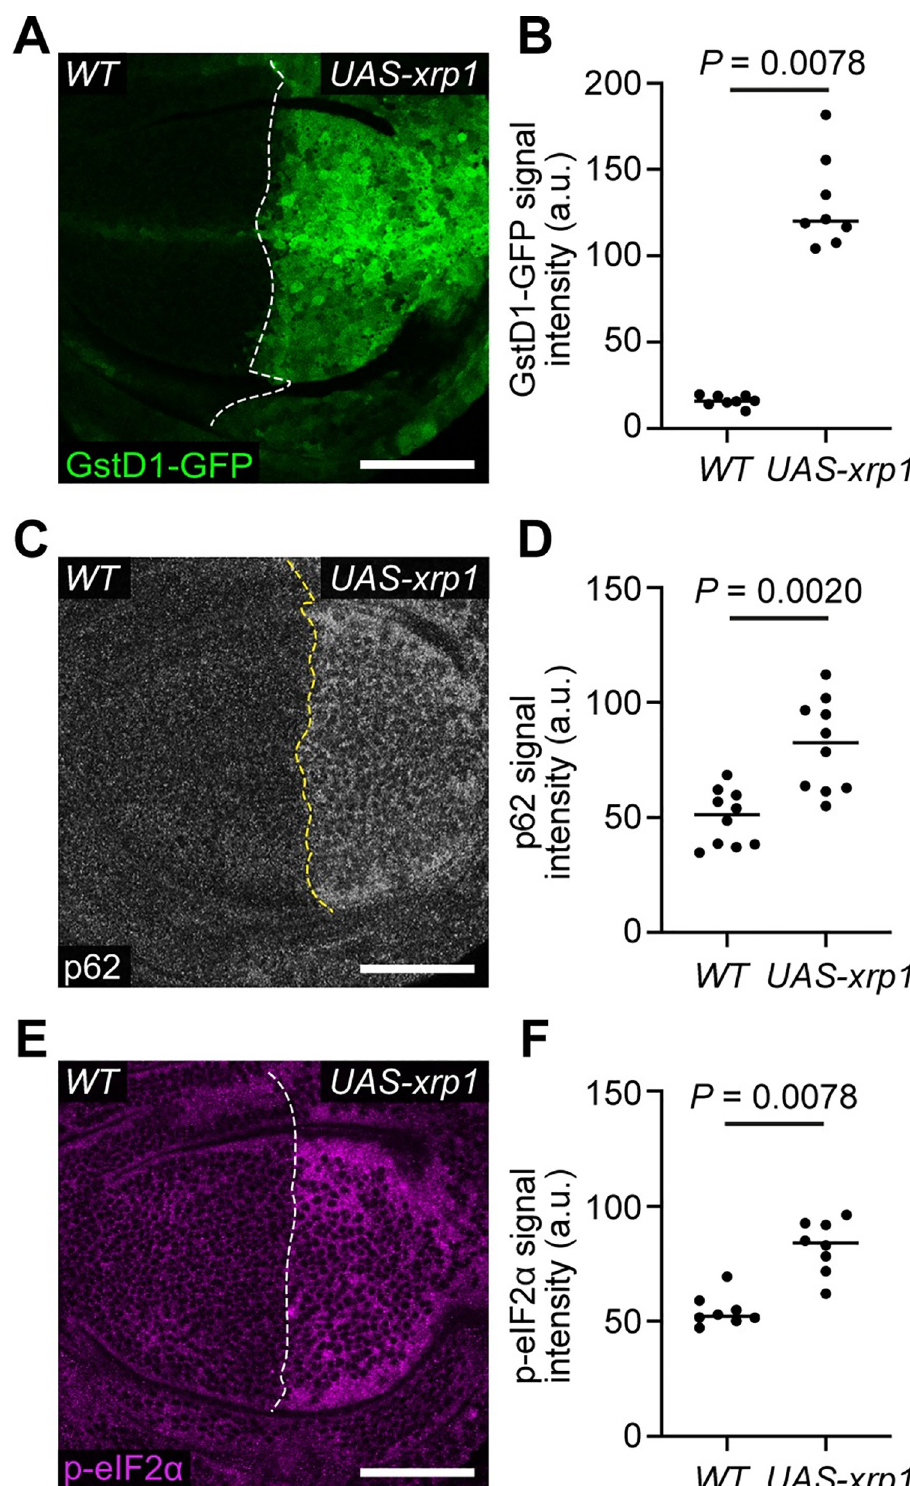
Fig 3. Xrp1 is sufficient for proteotoxic stress and the oxidative stress response. ( A-B ) A wild-type (WT) wing disc harboring GstD1-GFP (green) and over-expressing xrp1 ( UAS-xrp1 ) in the posterior compartment ( A ) with quantification of GstD1-GFP signal intensity ( B ) (n = 8; two-sided Wilcoxon signed-rank test). ( C-D ) A wing disc